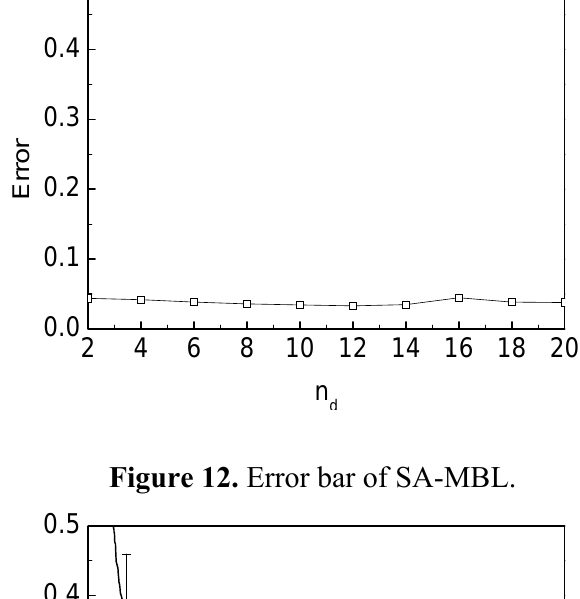
Figure 12. Error bar of